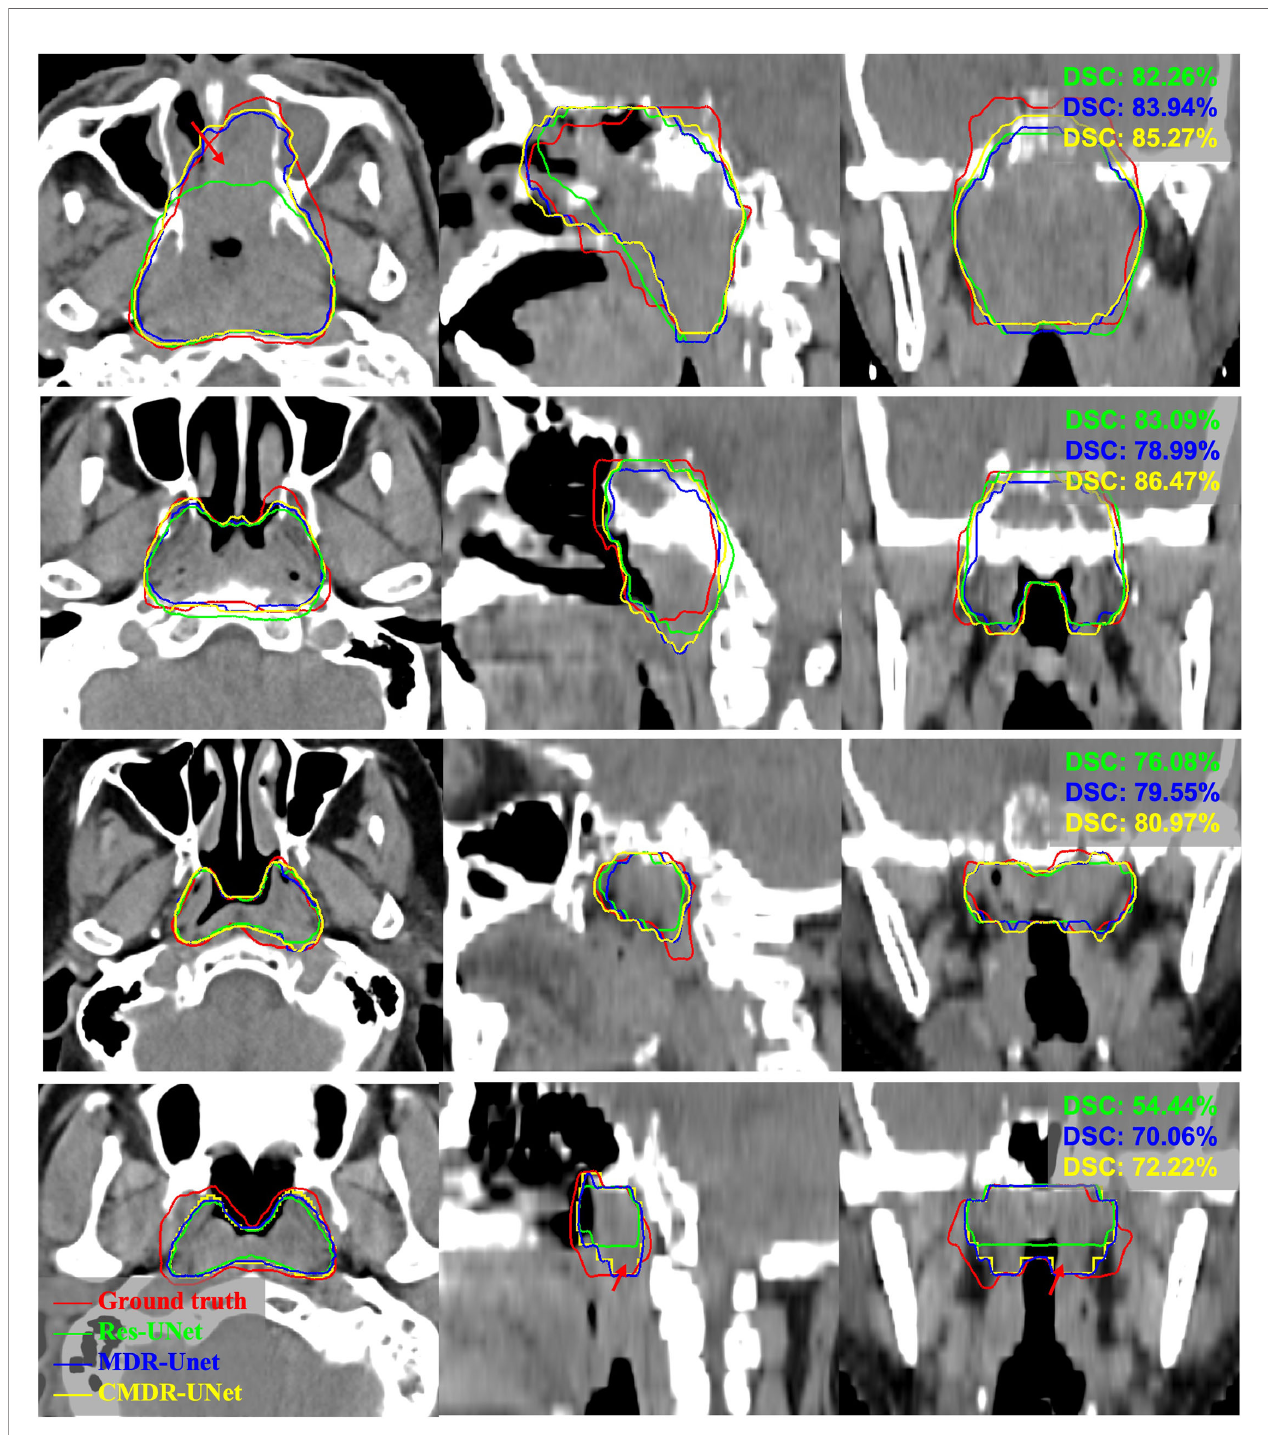
FIGURE 6 | Example pCT images show the level of consistency for GTVnx between the automatic delineation with our method and the ground truth. Red lines denote the human expert-delineated ground truth, and the other lines denote the contours of the automatic